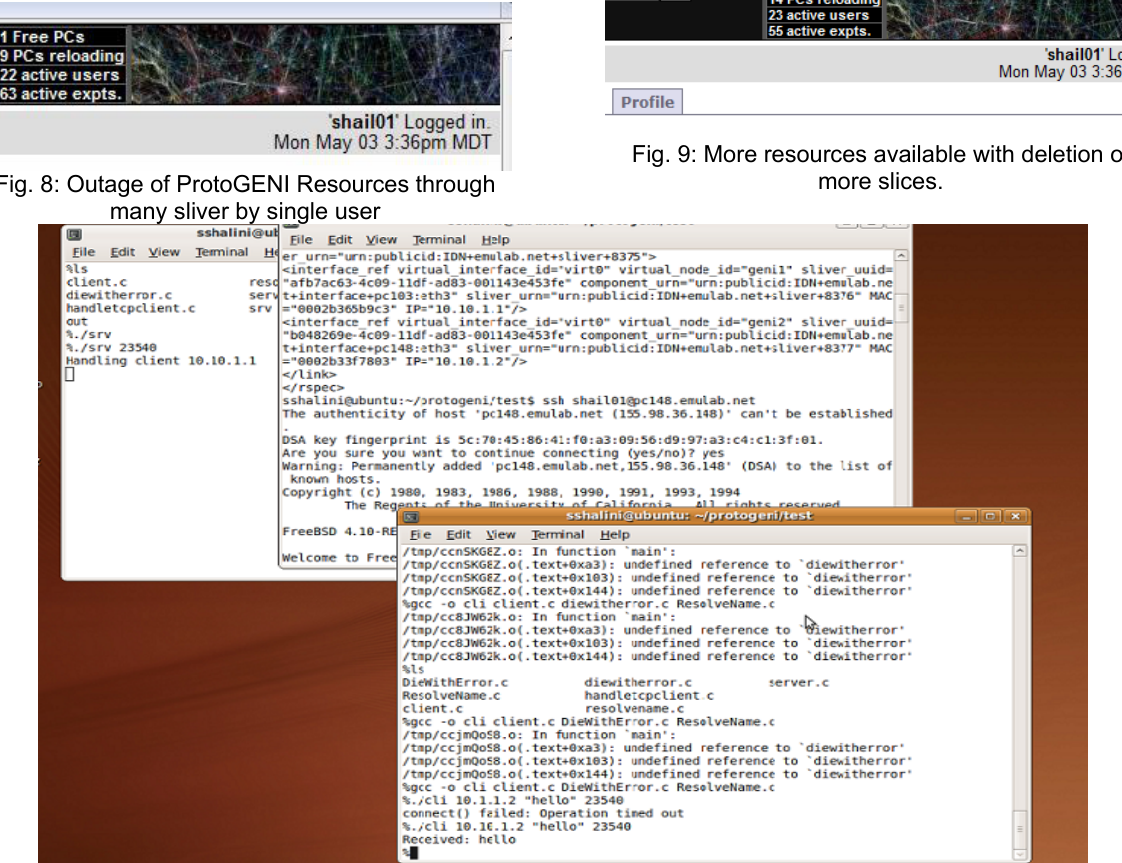
Fig. 10: Communication between Client and Server